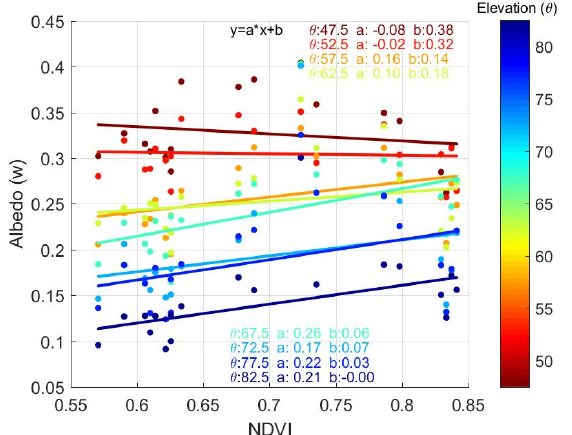
Figure 16. Comparison between the estimated single scattering albedo ( ω ) and the NDVI for different satellite elevation angles, and linear fits. Table 3. ω vs. NDVI Fitting